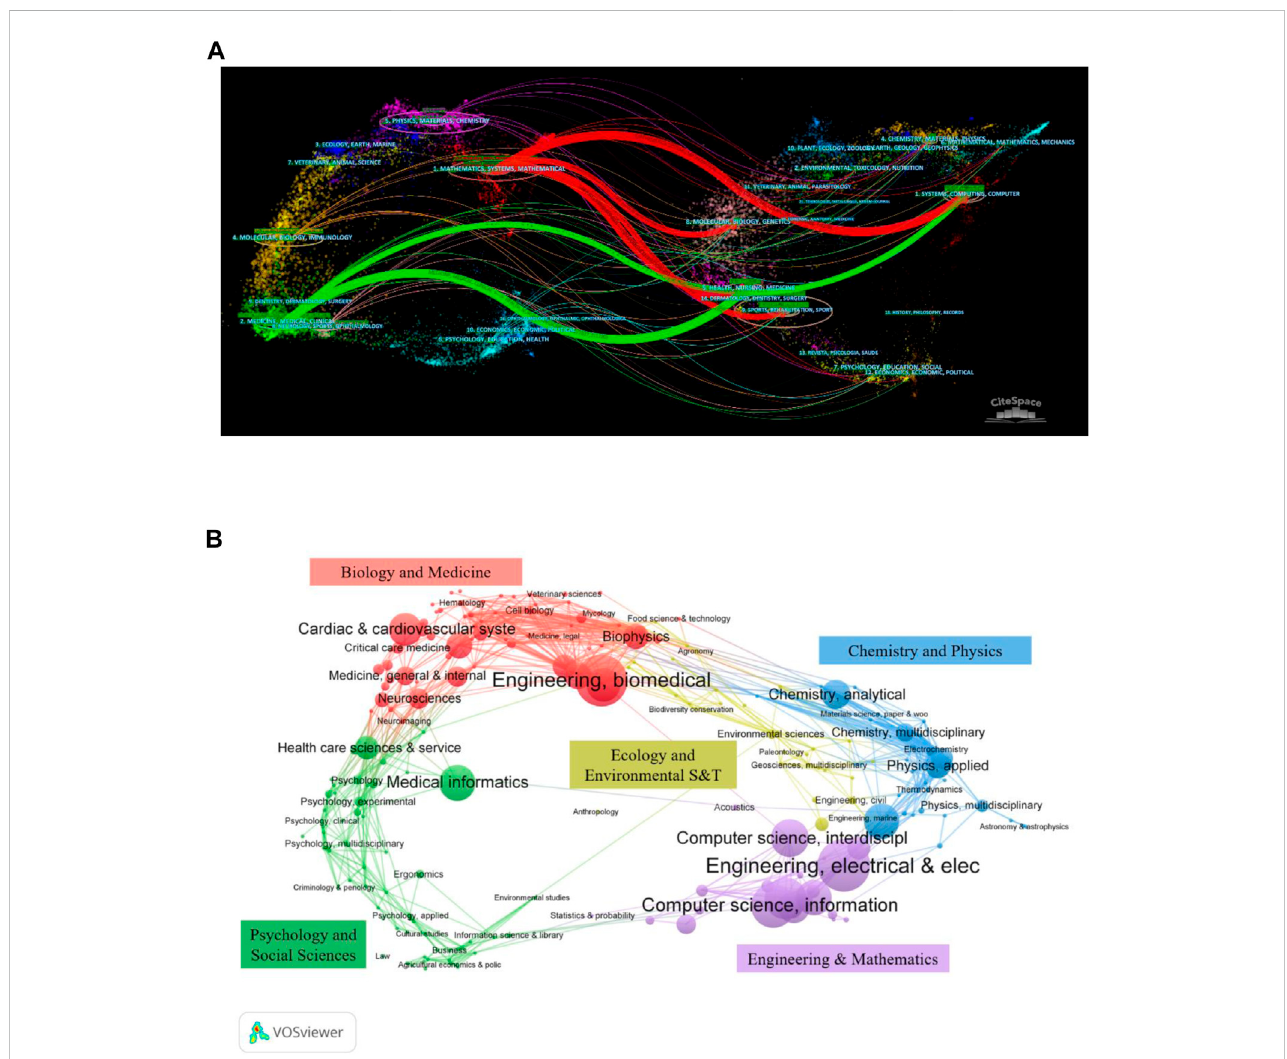
FIGURE 6 (A) The dual overlap map of journals on AI in ECG by using CiteSpace. (B) The subject category distribution on AI research in ECG was carried out by VOSviewer.